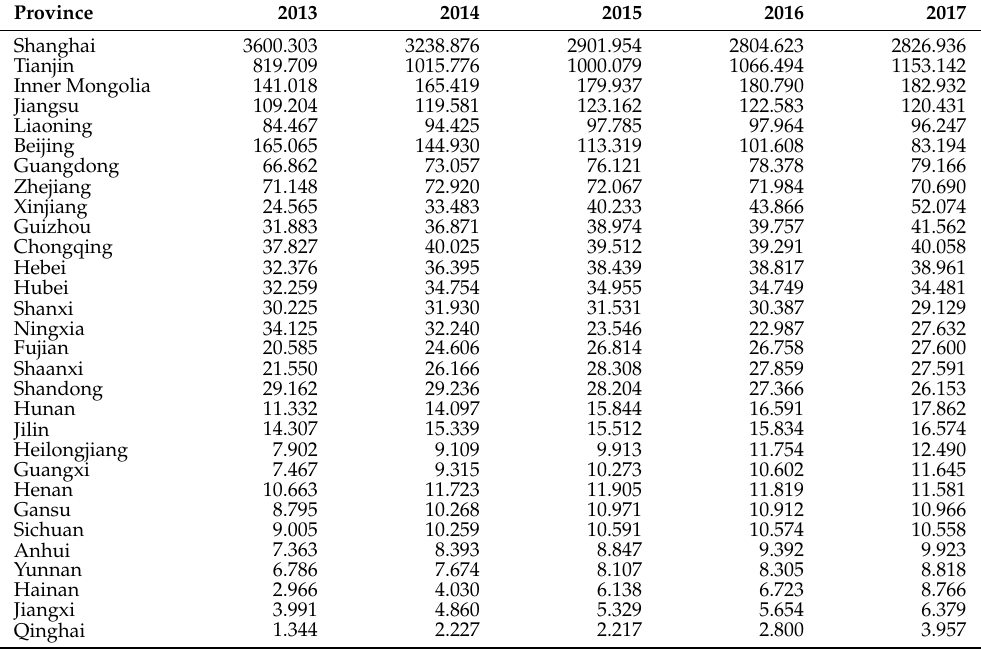
Table A12. The intra-provincial carbon inequality estimation results of original carbon emission data based on a 5-year rolling window for 30 provinces in China from 2013 to